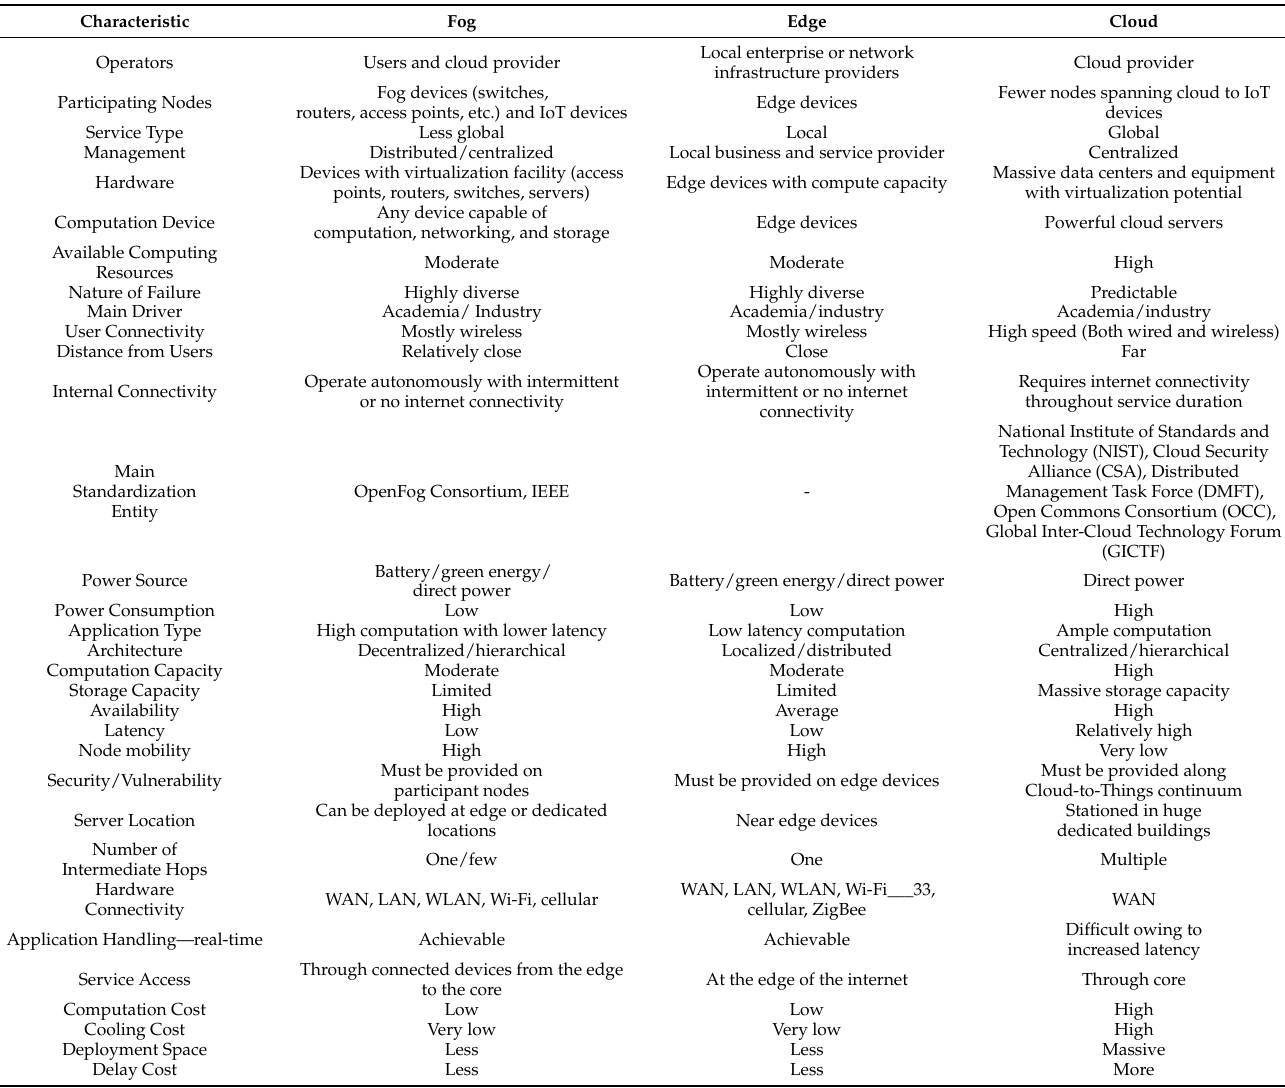
Table 3. Comparison of fog, edge and cloud computing characteristics.